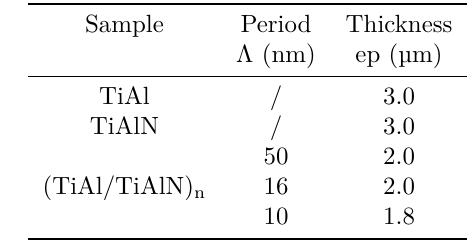
Table 1. Sample characteristics.